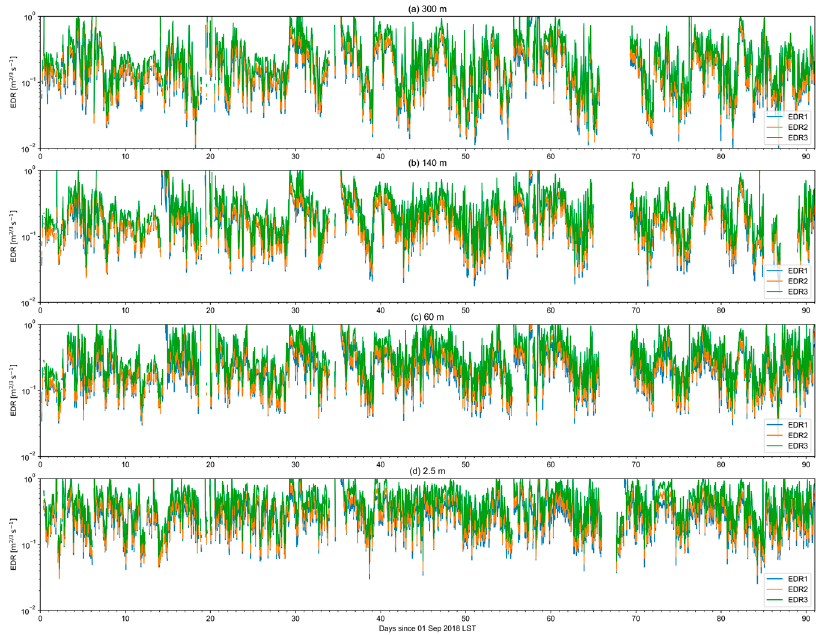
Figure 5. Time series of 30-min block averaged (red) EDR1, (orange) EDR2, and (green) EDR3 at ( a ) 300 m, ( b ) 140 m, ( c ) 60 m, and ( d ) 2.5 m in SON. Empty space indicates that EDRs were not produced and set to missing at the given time.